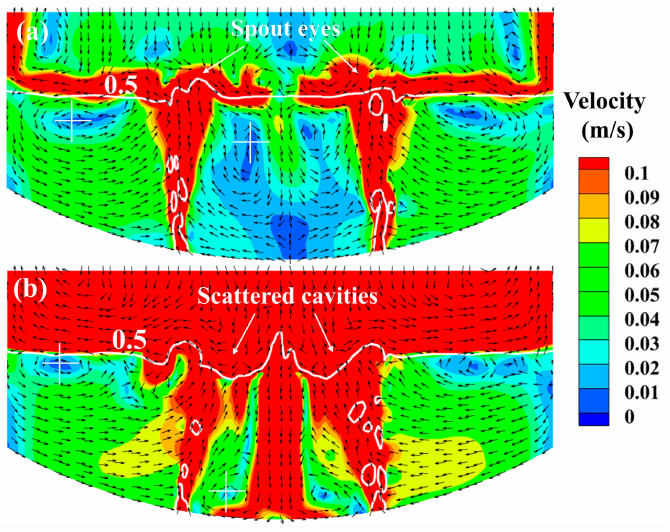
Figure 4. Comparison of the flow field in longitudinal section of the molten bath under ( a ) bottom blowing condition and ( b ) combined blowing